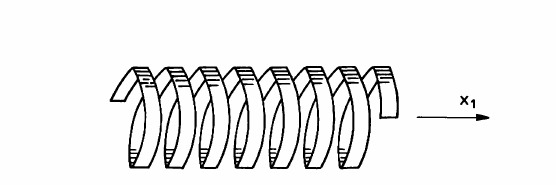
FIGURE 5 A helix as a wave-bearing